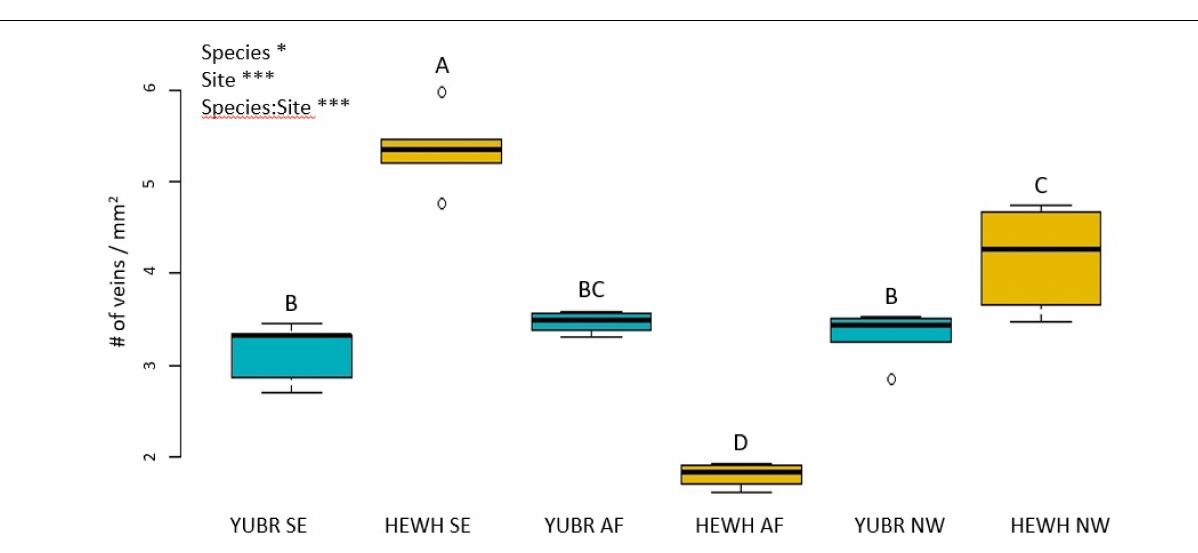
FIGURE 8 | Number of veins per mm 2 area varied across sites and had significant species-site interactions. Different letters denote statistically significant differences ( p < 0.05) by single-factor ANOVA followed by a Tukey-Kramer post hoc test. YUBR = Y. brevifolia ; HEWH = H. whipplei ; SE, south-eastern slope; AF, alluvial fan; NW, north-western slope. n = 5 leaves per species per site. *** p < 0.001; * p <